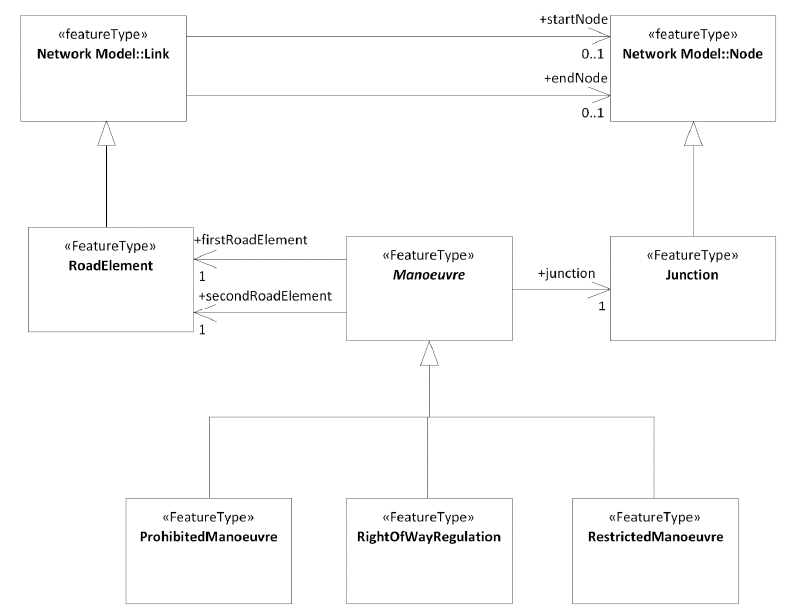
Figure 14. ISO 19109 compliant model of GDF 5.0 PedestrianCrossing.